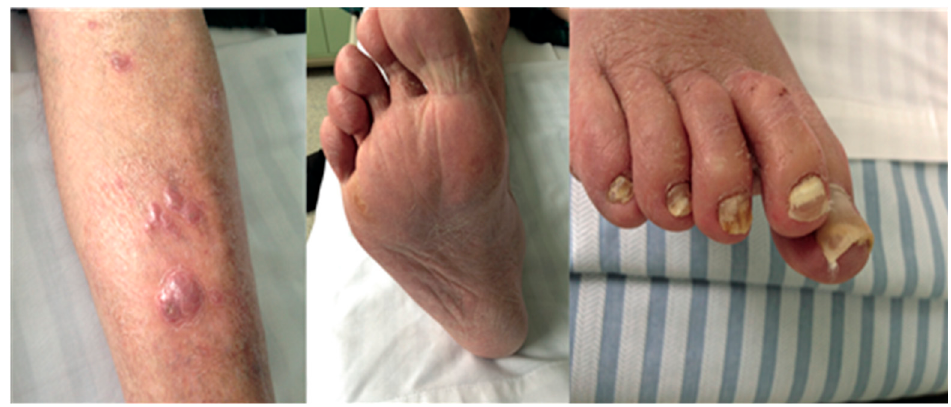
Figure 1. Purple nodules on the leg, interdigital and scaly lesions of the foot, proximal and total diffuse onychomycosis in a solid organ transplant patient diagnosed with deep dermatophytosis caused by T. rubrum .